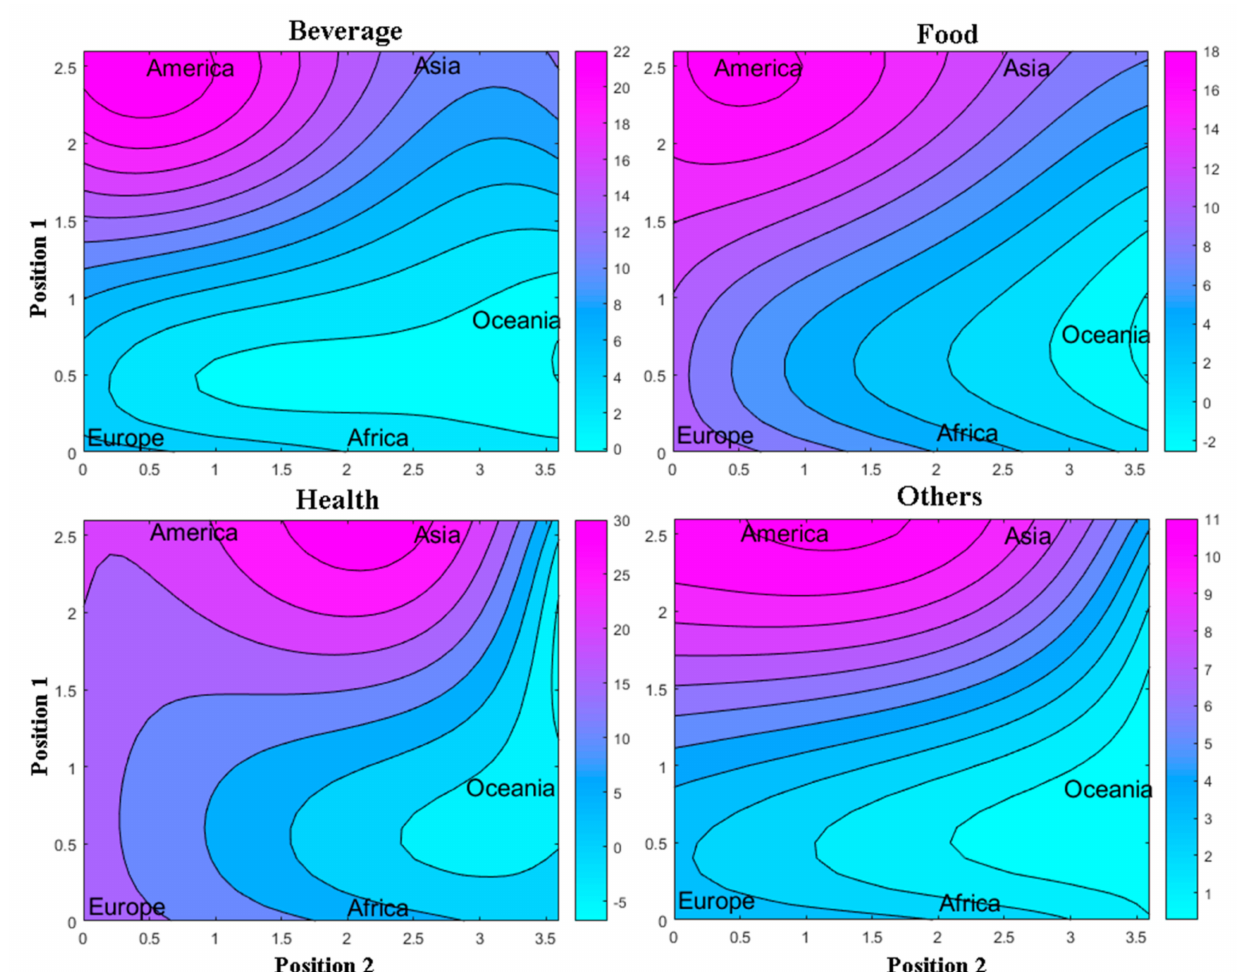
Figure 6. Weight maps overlaid by topological maps for the variables: continents. Position 1 and Position 2 indicate the position of the winning